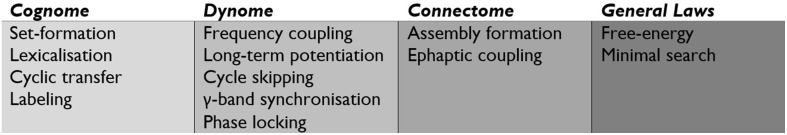
The central operations implicated by the Basic Label model of the cognome, dynome, and connectome, along with more general laws.